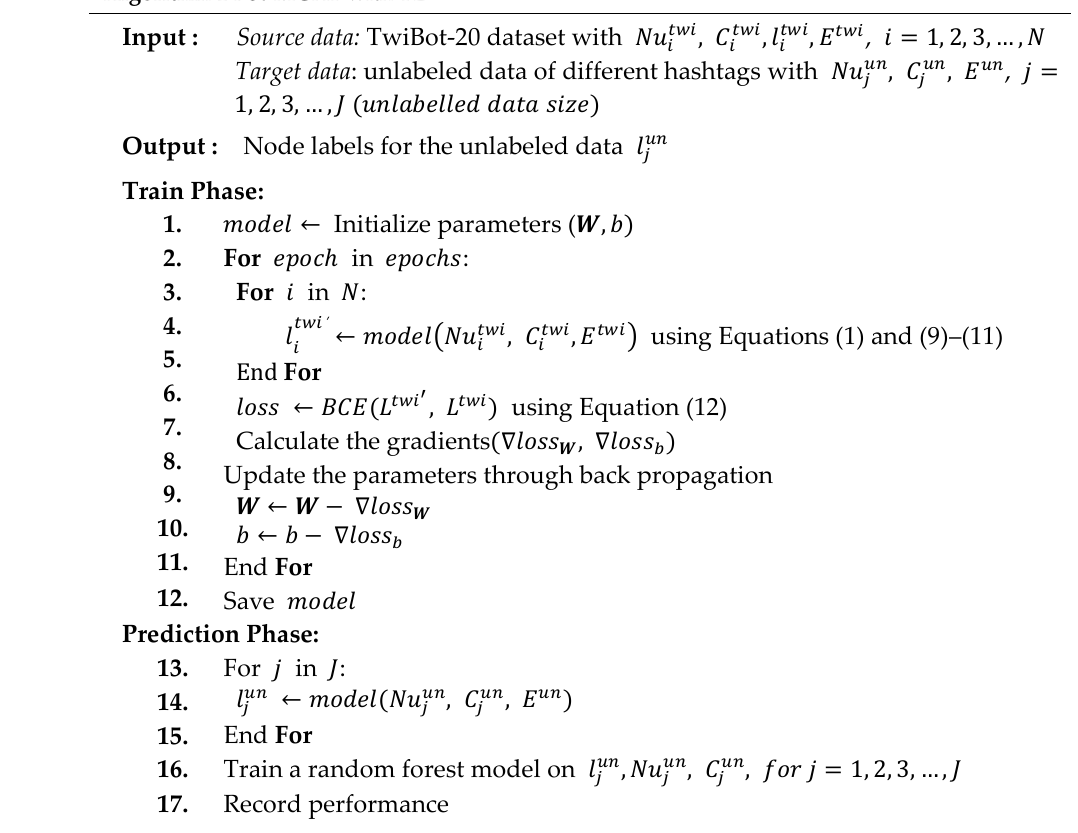
Table 4. Bot-MGAT